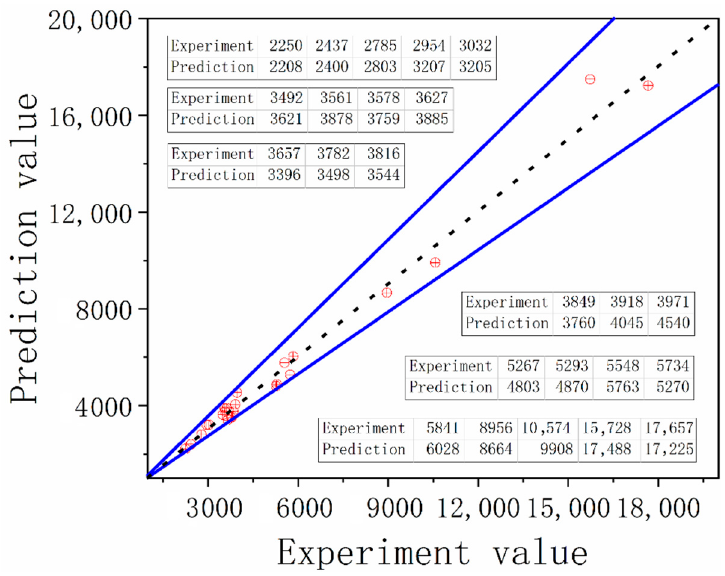
Figure 15. Comparison of the test value of creep–fatigue experiment with the predicted